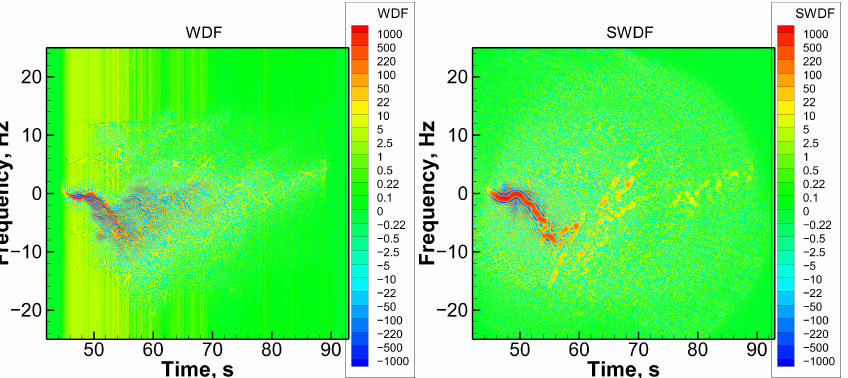
Figure 10. COSMIC-2 setting RO event observed on 15 May 2020 UTC 20:05, 16.69 ◦ N 163.45 ◦ W. Left: WDF, right: SWDF.